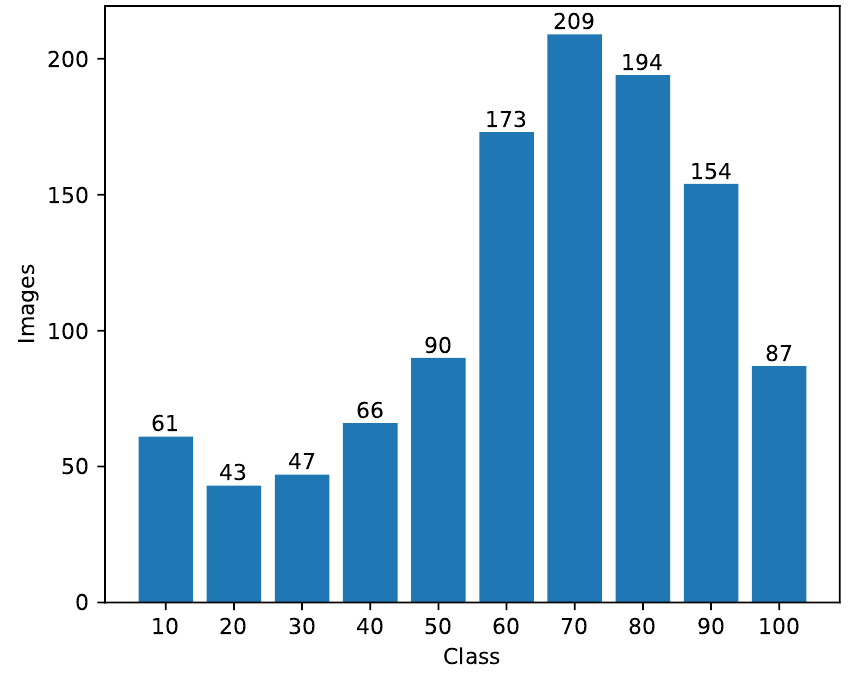
Figure 9. Class attribute y distribution. Table 5. Intersection areas of the histogram shown in Figure 8. Best results presented in